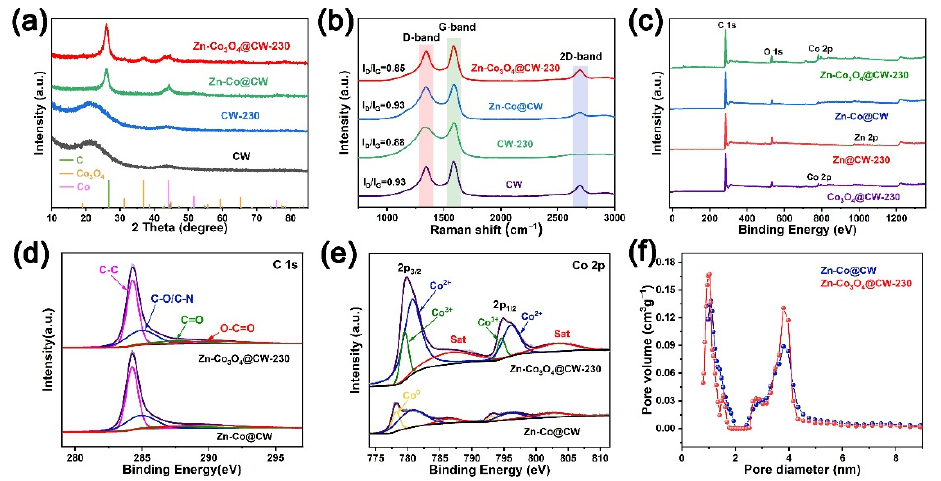
Figure 3. ( a ) XRD spectra of CW, CW-230, Zn-Co@CW, and Zn-Co 3 O 4 @CW-230; and Raman spectra ( b ). XPS spectra of ( c ) full scan survey for Co 3 O 4 @CW-230, Zn@CW-230, Zn-Co@CW, and Zn- Co 3 O 4 @CW-230. High-resolution XPS spectra of Zn-Co@CW and Zn-Co 3 O 4 @CW-230 for ( d ) C 1s and ( e ) Co 2p; and ( f ) corresponding pore size distribution.